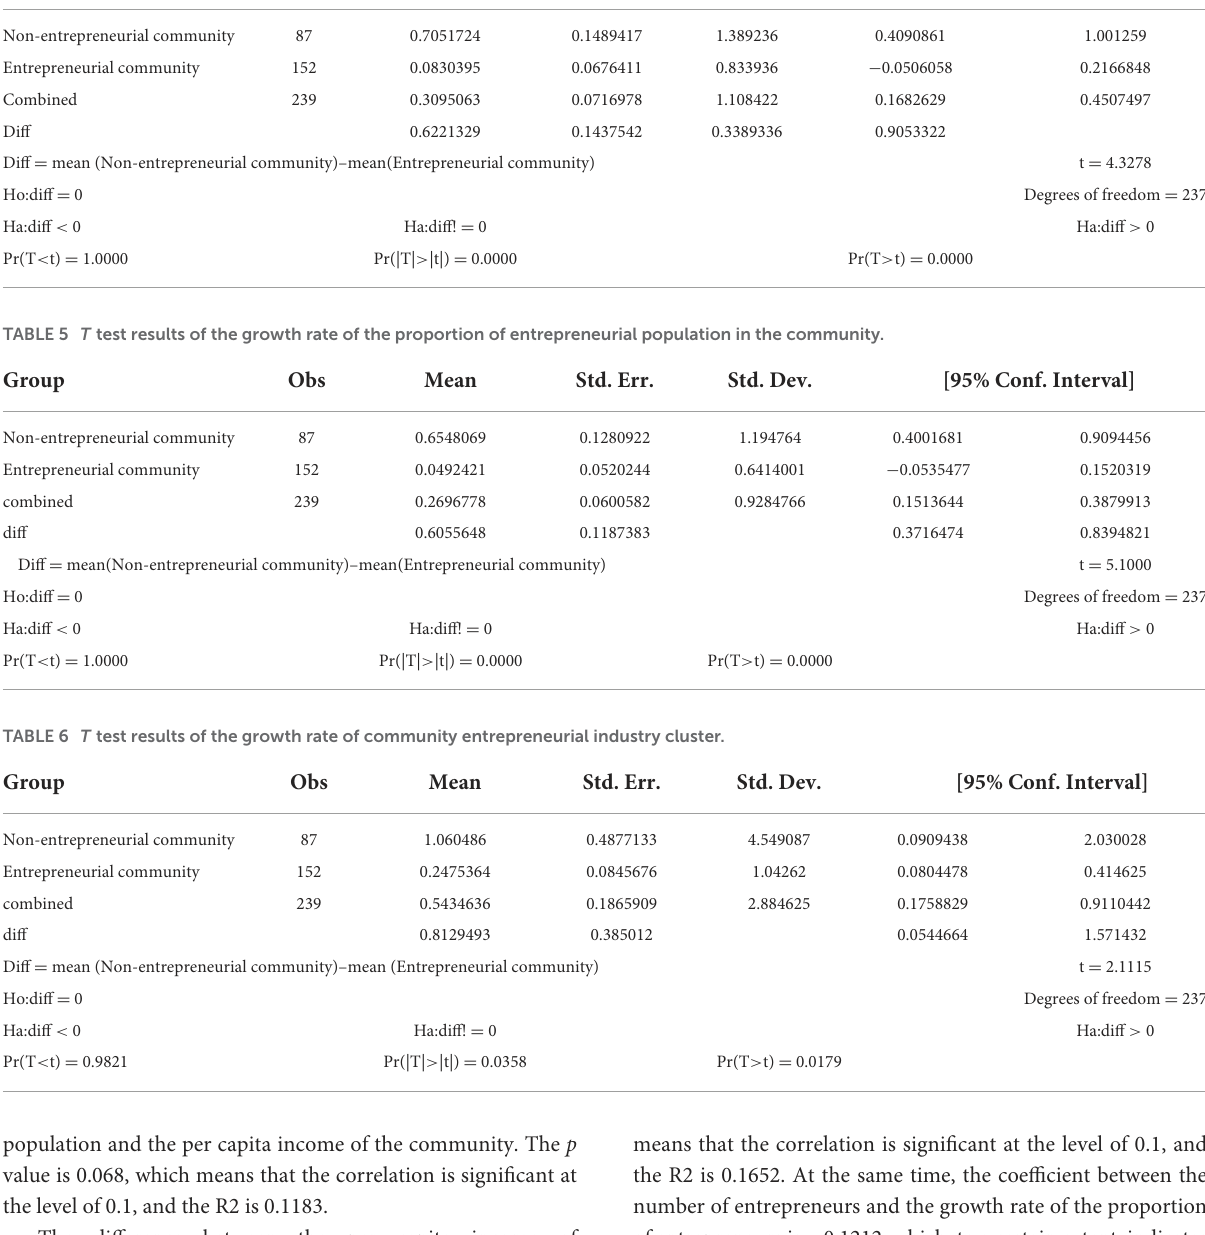
TABLE 4 T test results of the growth rate of entrepreneurial population in community. Group Obs Mean Std. Err. Std. Dev. [95% Conf. Interval]